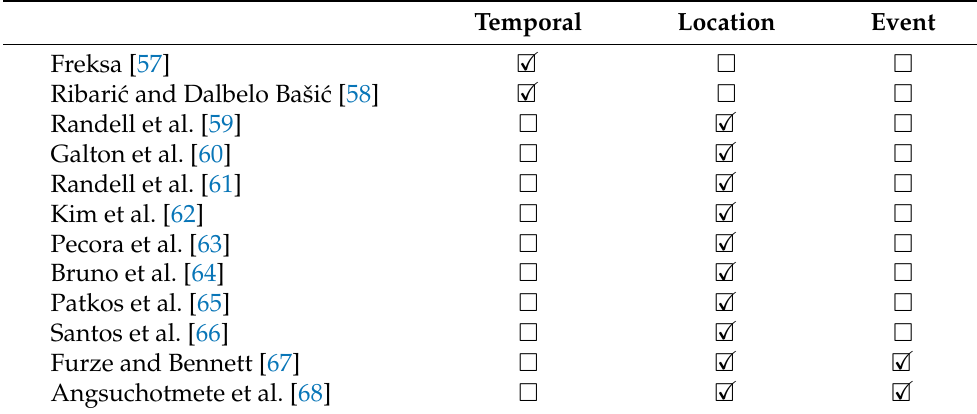
Table 6. Spatial, temporal and event